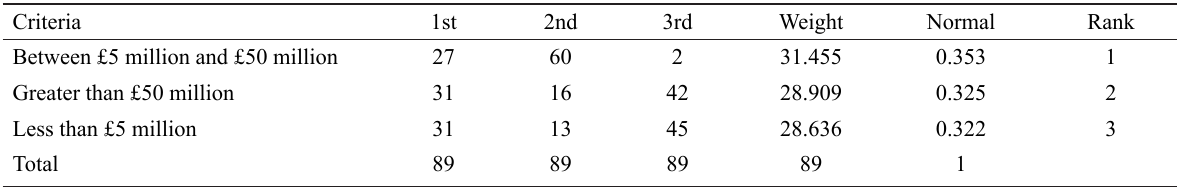
Table 8. Value of project that allows an SME to maximise rewards and minimise risks Criteria